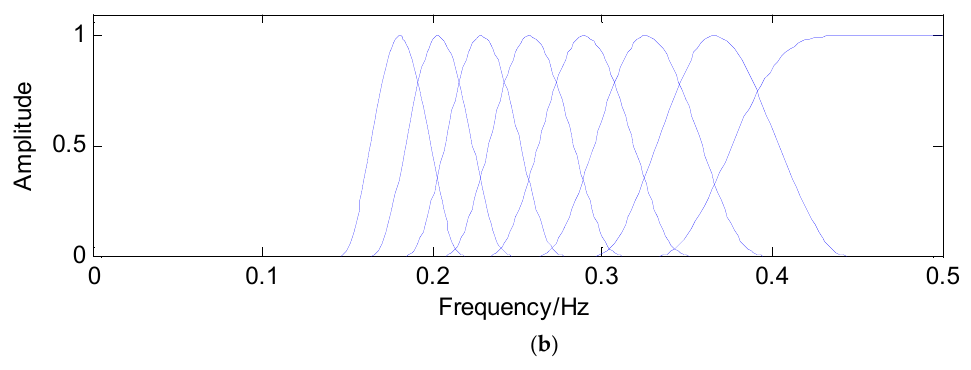
Figure 2. Frequency response with different Q-factor values ( a ) Q = 1, R = 3; ( b ) Q = 5, R = 3.